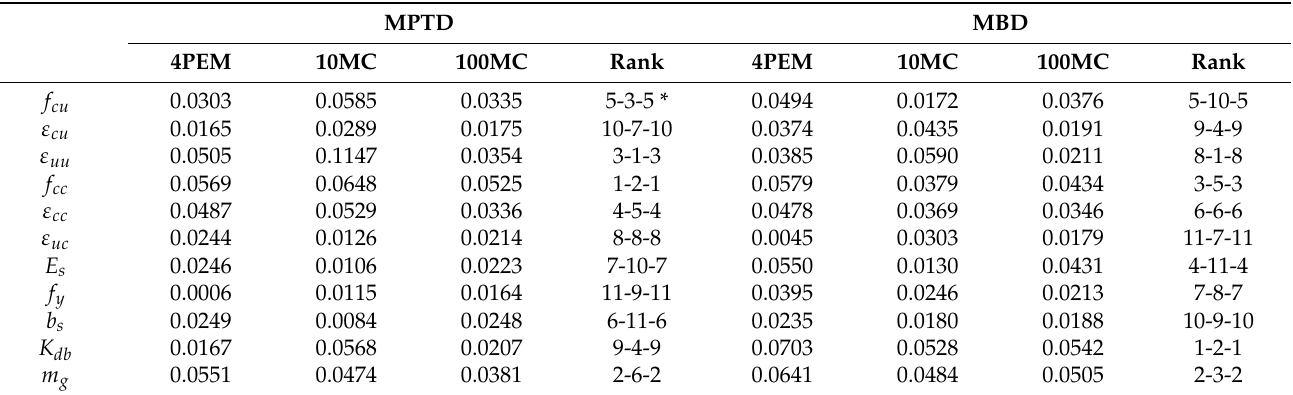
Table 2. MII indexes of uncertain parameters.